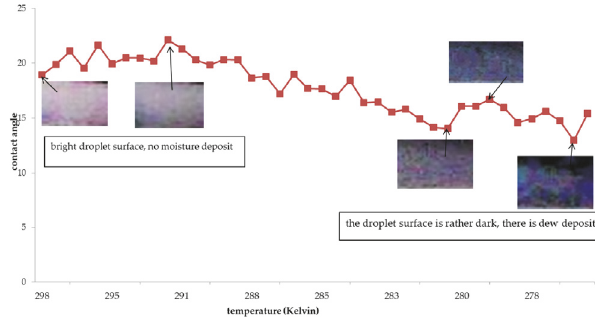
Figure 6: Slope of (-d 𝛼 /dT) vs